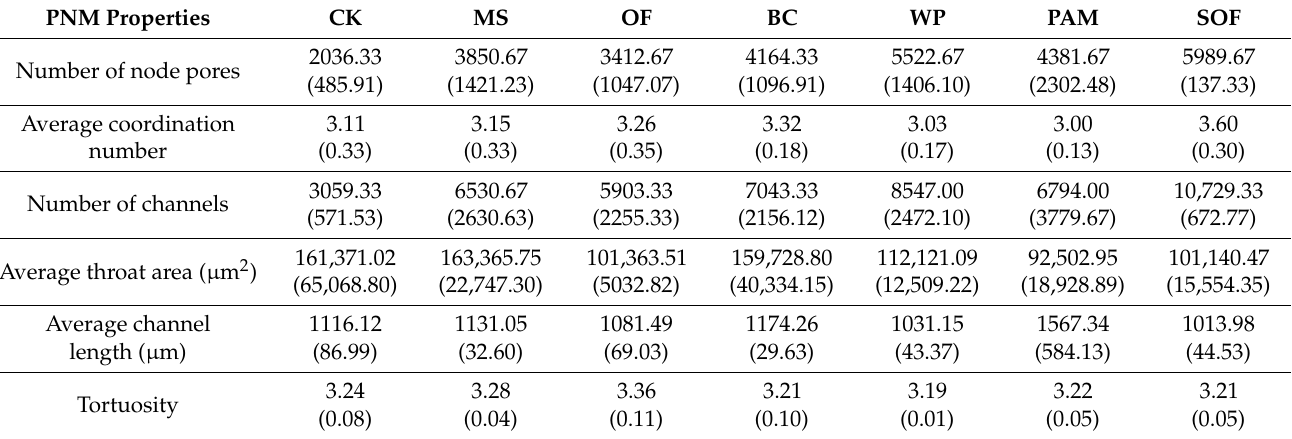
Table 5. Quantification of the pore network of the soil cores with different organic treatments.